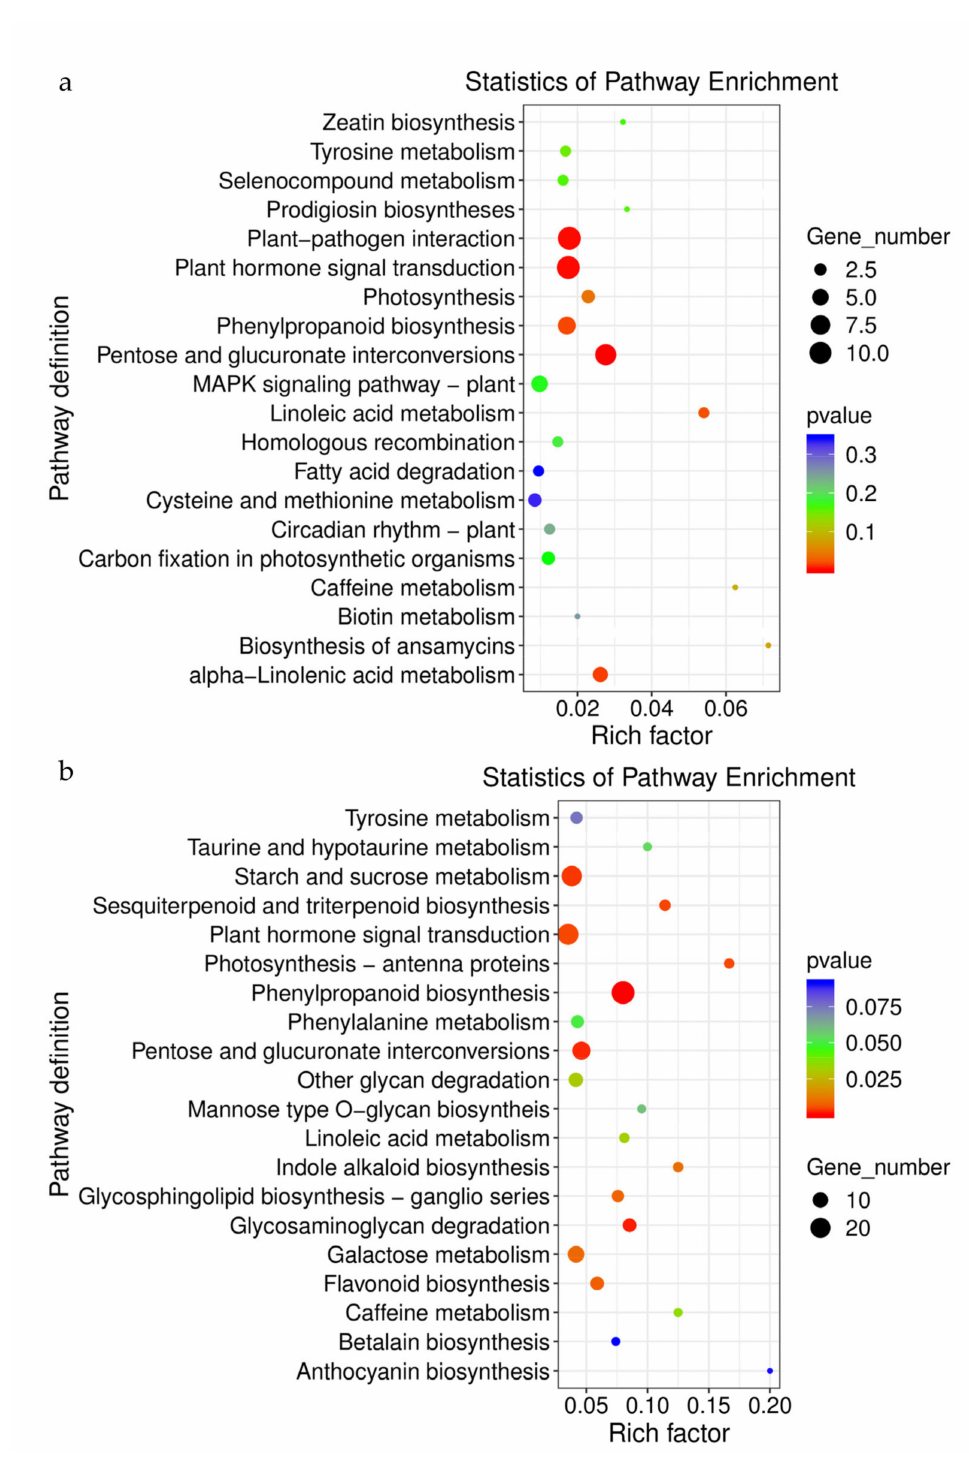
Figure 7. KEGG enrichment of differential gene: 13 d vs. 1 d ( a ) and 27 d vs. 1 d ( b